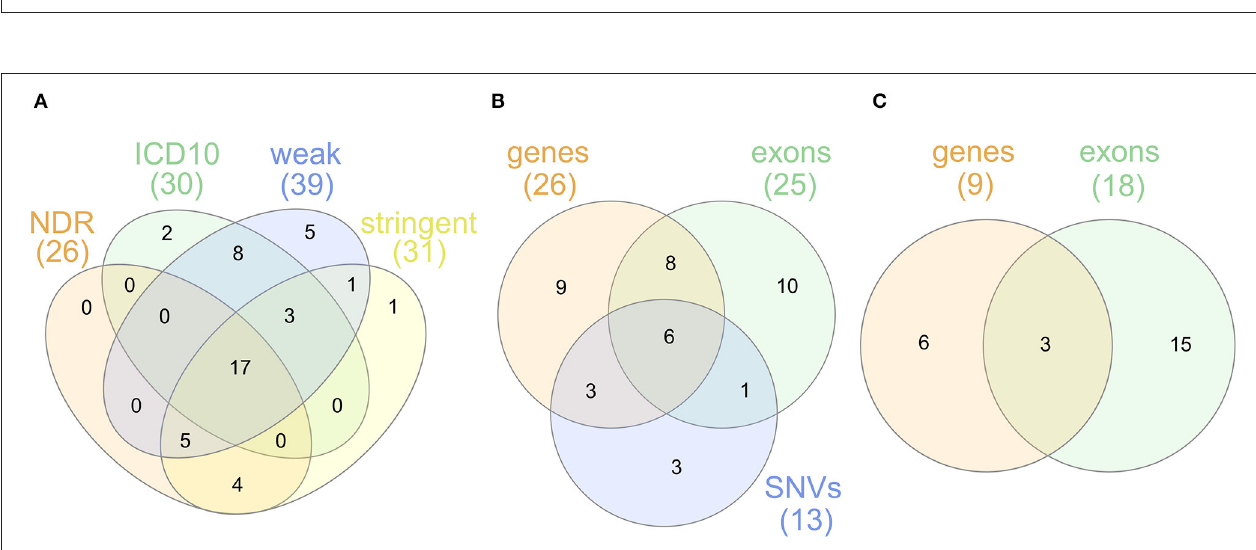
single-SNV analysis. TNXB was identified in the exon-based and the single-SNV analysis. (C) Venn diagram for genes found to be significantly associated with NDR-defined T1D in the gene- or exon-based test using the linear-weighted SKAT model. Three genes ( HLA-DOB, TNXB, and EHMT2 ) were identified in both